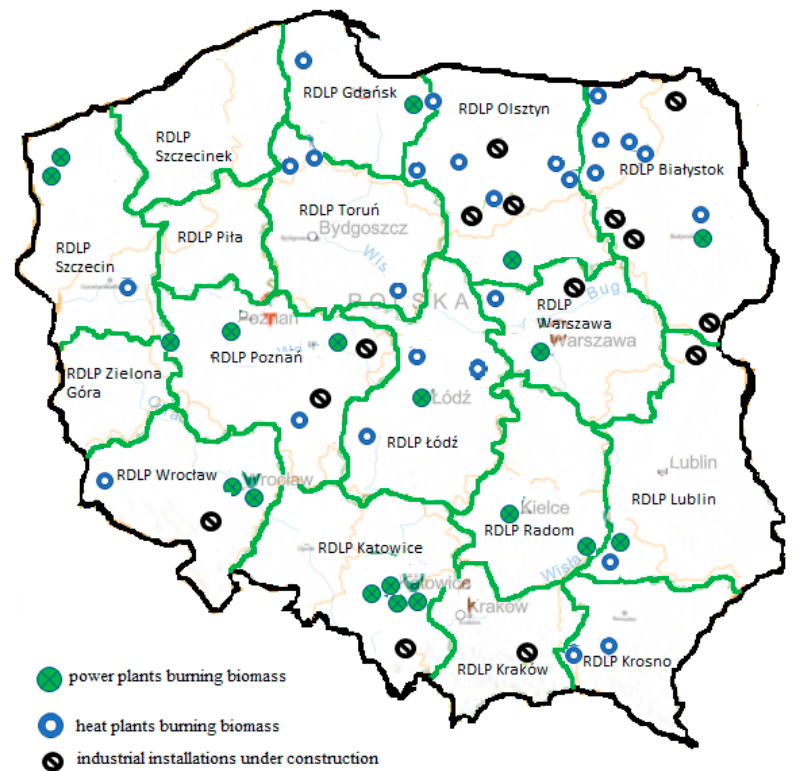
Figure 4. Distribution of existing and planned installations burning biomass to produce electricity or heat. Source: own study based on the contact details of companies.